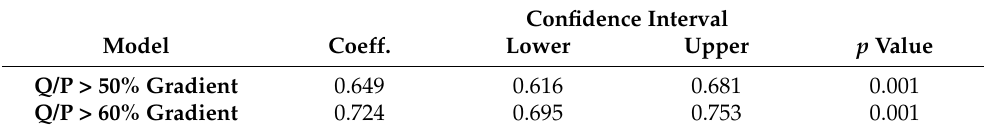
Table 6. Inferential statistics of Equations (10) and (11) at α = 0.05. Confidence Interval BCa Model Coeff. Lower Upper p Value Q/P > 50% Gradient